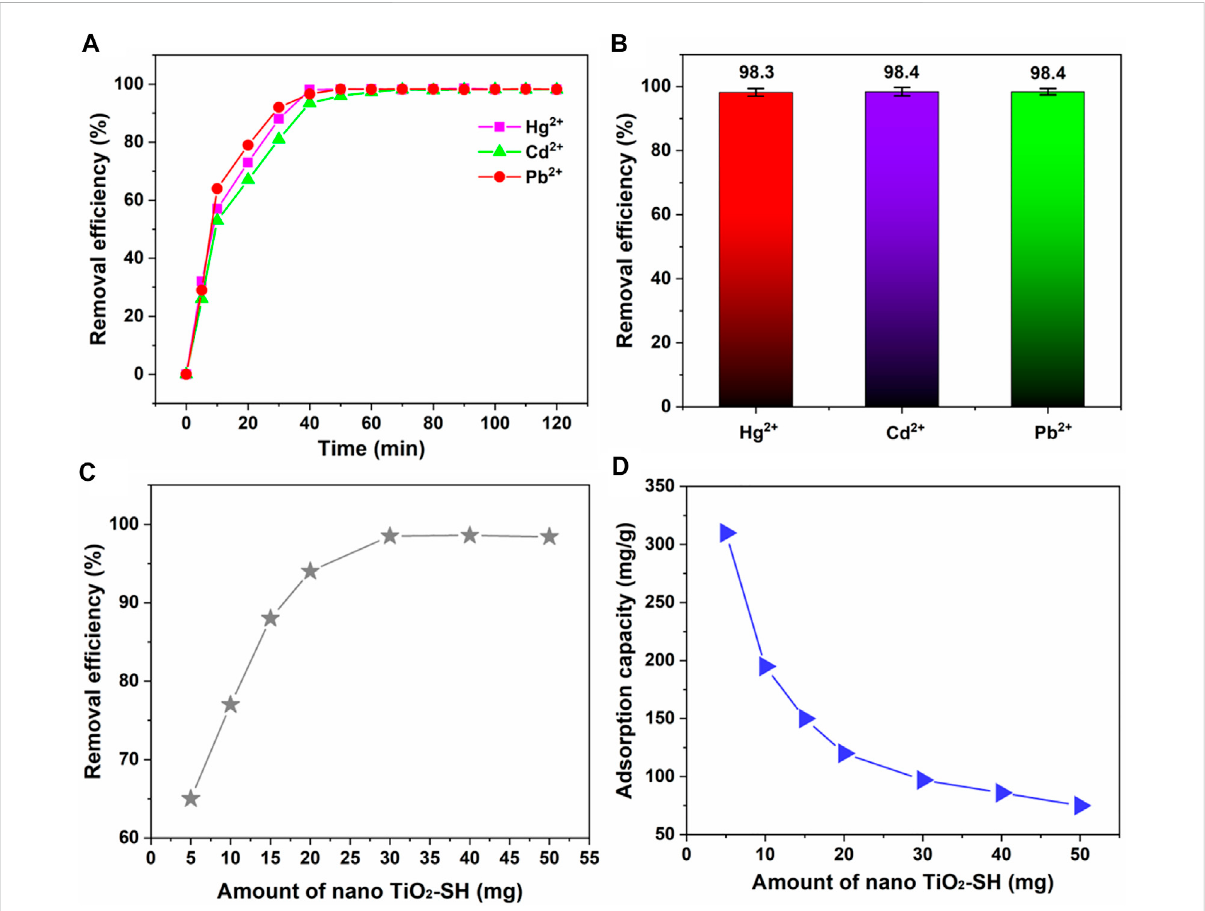
FIGURE 5 (A) The adsorption equilibrium time curve of nano TiO 2 -SH for heavy metal ions (Hg 2+ , Cd 2+ and Pb 2+ ), (25 ° C, pH = 8). (B) The maximum adsorption ef fi ciency of nano TiO 2 -SH for heavy metal ions. (C,D) In fl uence of the amount of nano TiO 2 -SH on the adsorption ef fi ciency and adsorption capacity of heavy metal